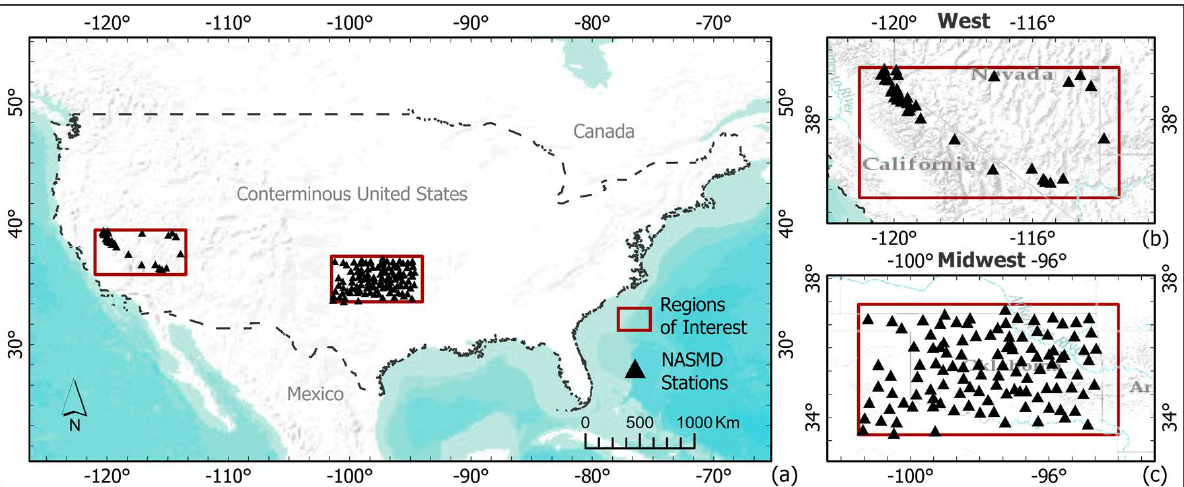
Figure 2. ( a ) North American Soil Moisture Database (NASMD) stations over the two ROIs available in 2010; ( b ) West ROI; and ( c ) Midwest ROI.